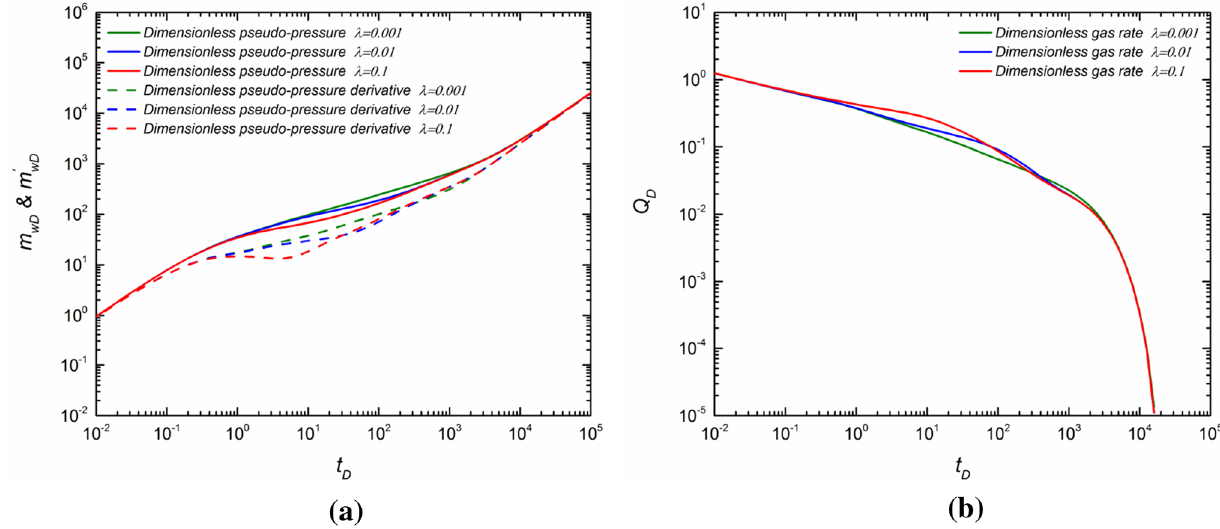
Fig. 6 Effect of inter-porosity flow coefficient on pseudo-pressure and rate curves. a Dimensionless pseudo-pressure and pseudo-pressure deriva- tive curve, b dimensionless rate